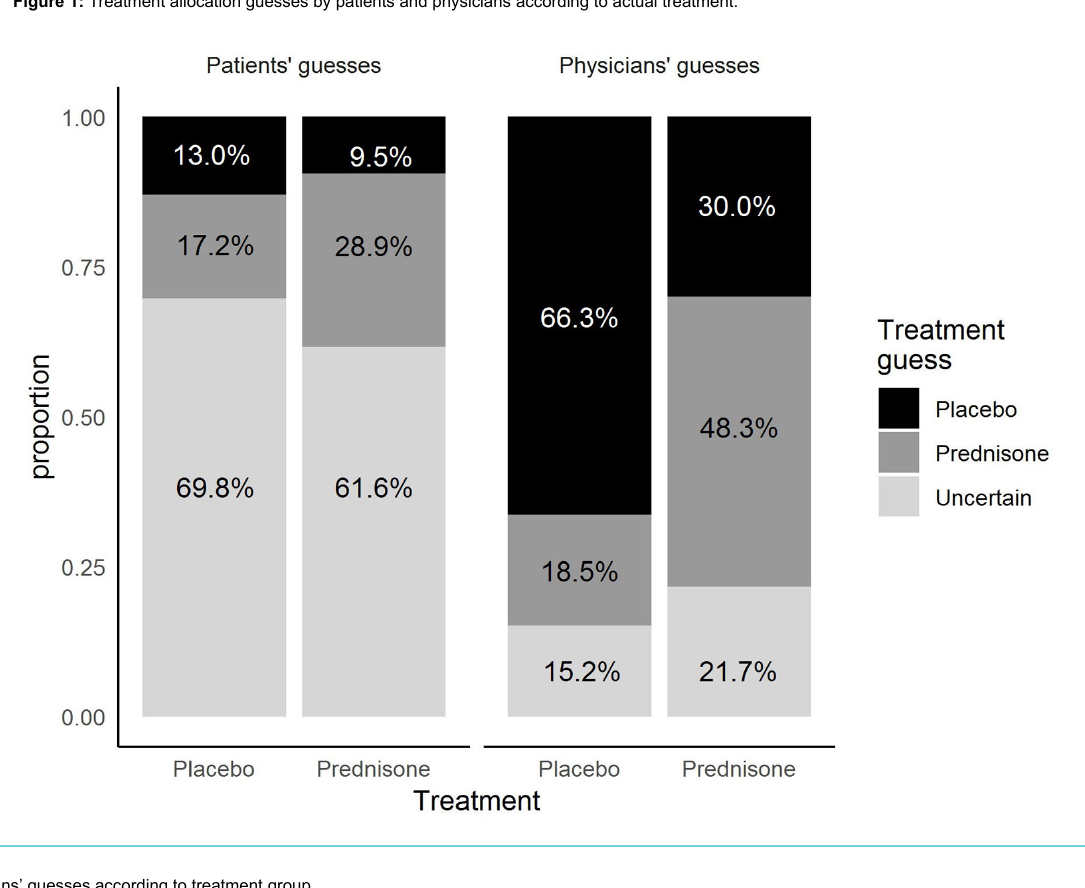
Figure 1: Treatment allocation guesses by patients and physicians according to actual treatment.